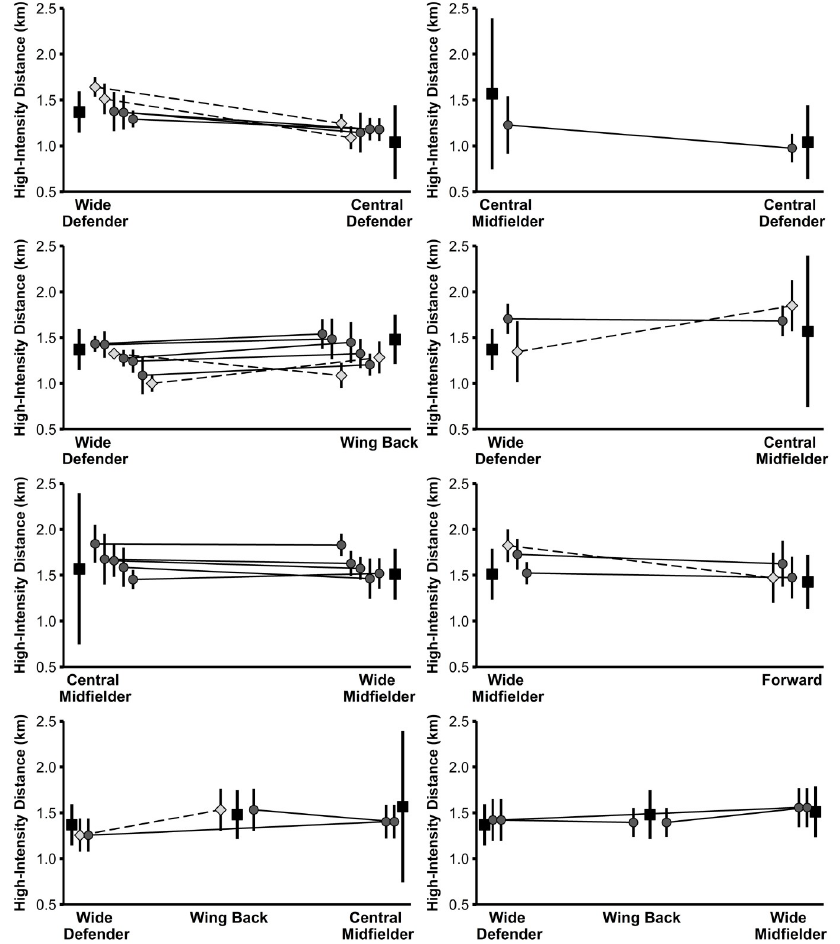
Fig 2. High-intensity distance of players from the study sample (grey diamonds and circles) in relation to normative positional data (black squares). Data are presented as mean values ± SD. Light grey diamonds and dashed lines indicate significant differences in performance between the two positions for the respective